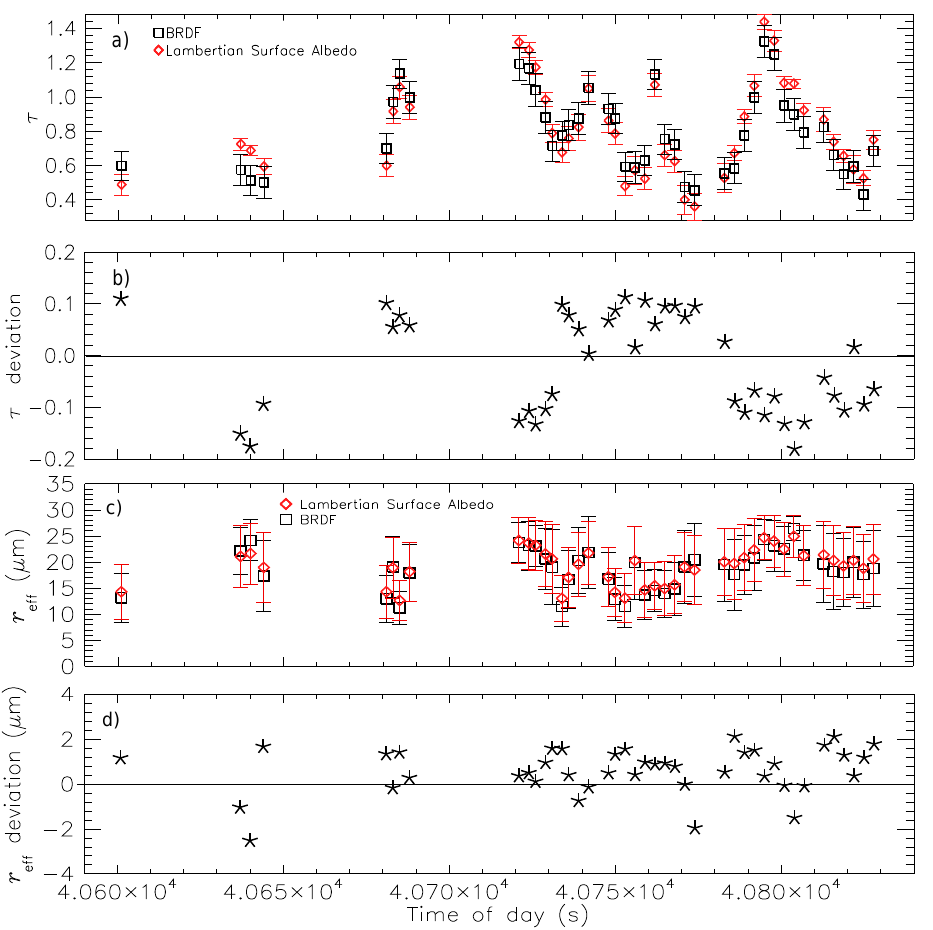
Fig. 19. (a) Comparison of mean values and standard deviations between retrieval using surface albedo approach 2 (HALO-SR) of τ using isotropic reflecting surface albedo (red diamonds) and BRDF (black squares) from the 4 November 2010 flight between 11:00 and 11:30UTC. (b) Corresponding numeric mean value deviation. (c) and (d) show the same for r eff . Time is given inUTC.